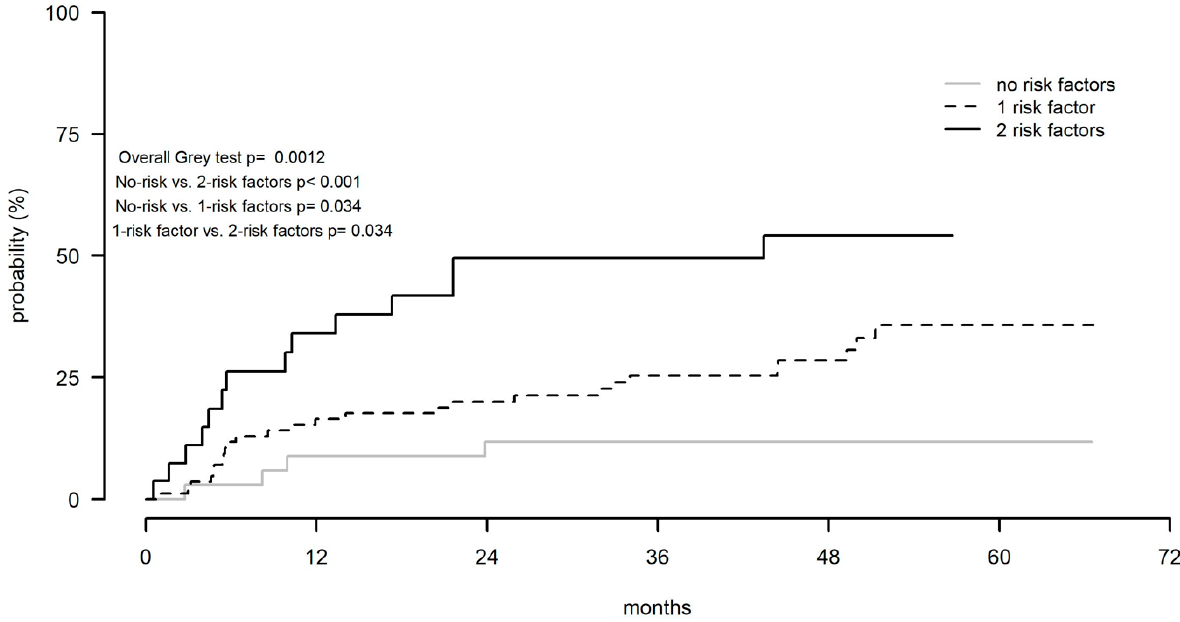
Figure 3. Cumulative rates of treatment discontinuations due to adverse events according to the number of risk factors.